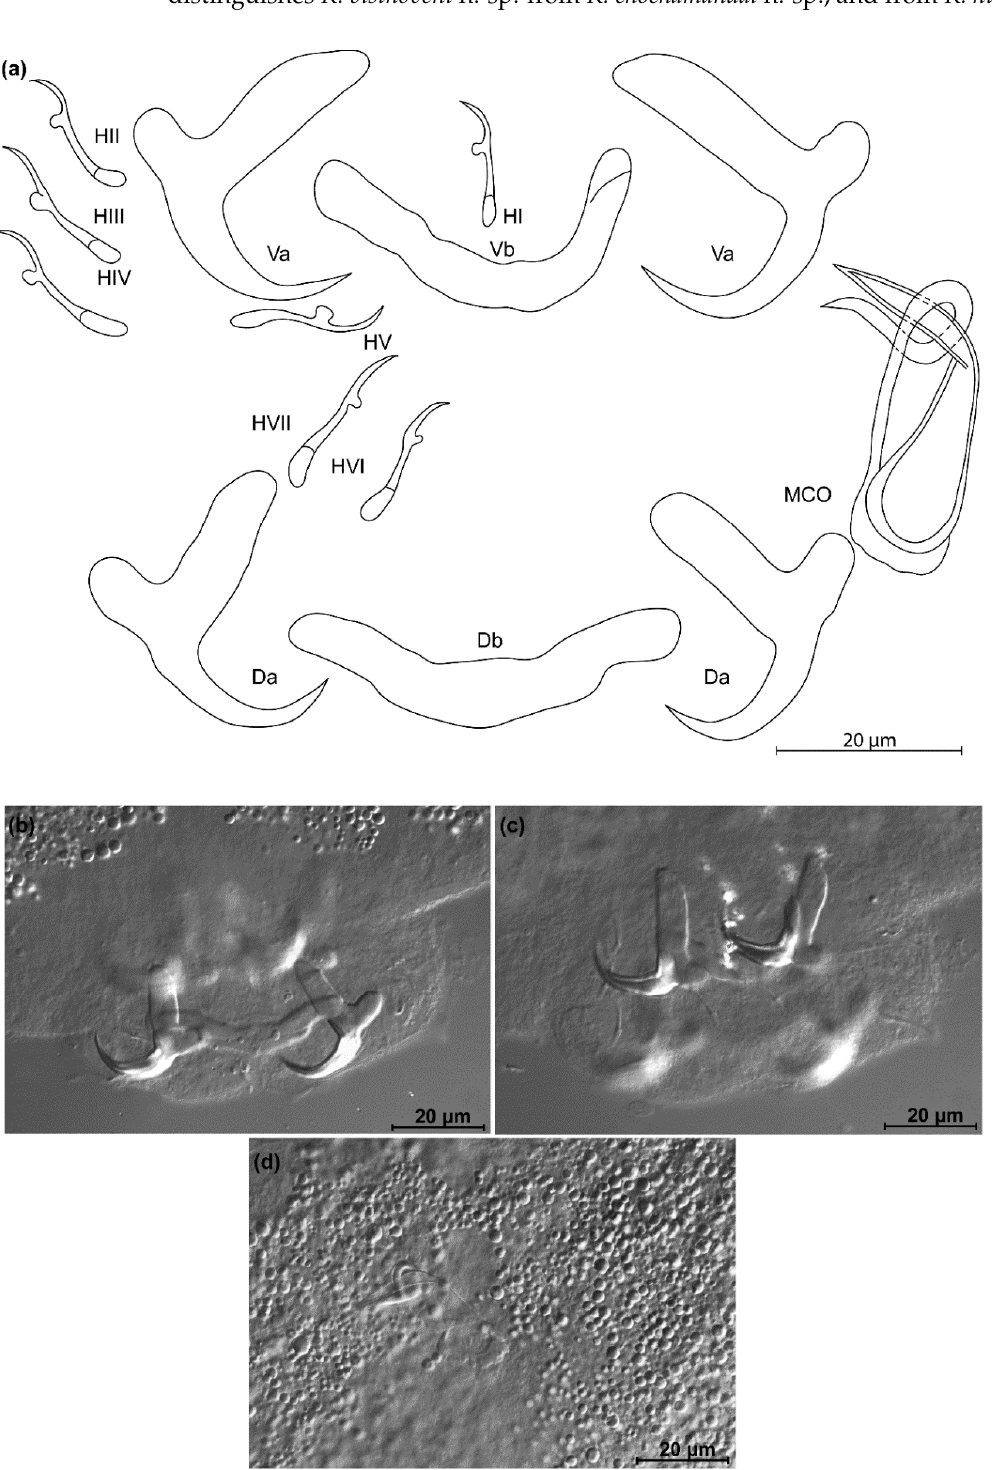
Figure 15. Kapentagyrus bisthoveni n. sp. (ex Microthrissa congica ). ( a ) Drawings of sclerotized structures, Va-ventral anchors, Db-dorsal bar, Vb-ventral bar, H-hooks (pairs I to V—ventral; pairs VI, VII—dorsal). ( b ) Micrograph of dorsal anchors and dorsal bar. ( c ) Micrograph of ventral anchors and ventral bar. ( d ) Micrograph of MCO.